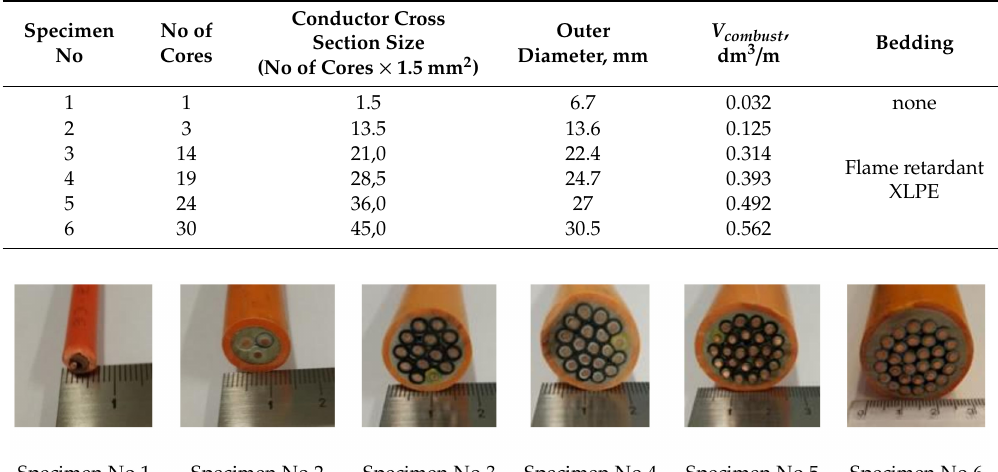
Table 1. Characteristics of cable samples: copper cores class 1, sheath made of EVA / ATH / ZnB compound, insulation made of mica tape, and silane cross-linked polyolefin (XLPO) compound.